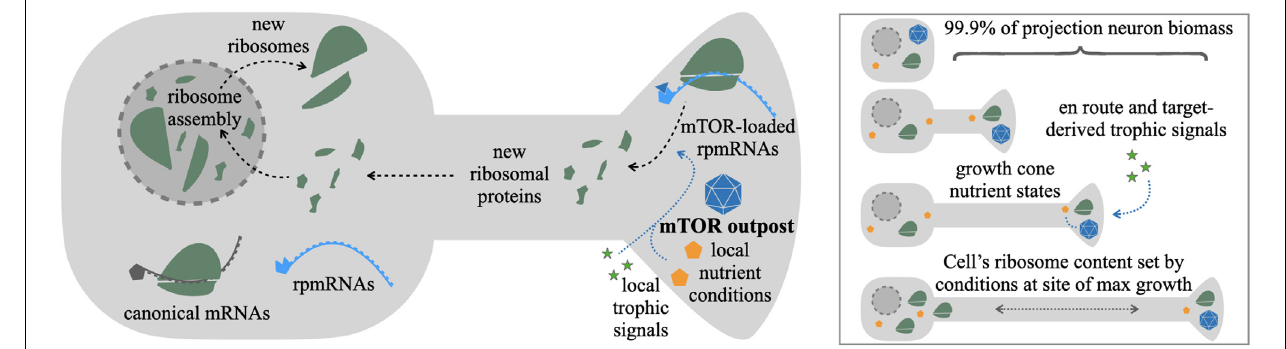
FIGURE 2 | mTOR outpost model in the regulation of ribosome content. New ribosomes are assembled in the nucleus from three rRNAs produced in nucleoli, and ∼ 80 ribosomal proteins imported from the cytosol, where each is translated from ribosomal protein mRNAs (rpmRNAs). rpmRNAs are consistently found enriched in distal processes of neurons. Unlike most canonical mRNAs (gray), rpmRNAs (cyan) have an atypical 5’ TOP motif that requires direct binding and activation by mTOR complexes (blue triangle) to initiate translation. The mTOR outpost model predicts that rpmRNA-rich processes with localized mTOR outposts (blue polyhedron) would be a major source of new ribosomal proteins (green). The rate of ribosomal protein production would depend on local growth-stimulating conditions at the mTOR outpost, such as nutrient availability (yellow pentagons) and local trophic signals (green stars). As a result, in developing projection neurons with mTOR outposts and rpmRNAs in distal axon growth cones, the rate of cell-wide ribosome production would be determined by target-derived trophic signals and the local metabolic conditions at the axon growth cone, the sites of growth for the majority of a projection neuron’s biomass.